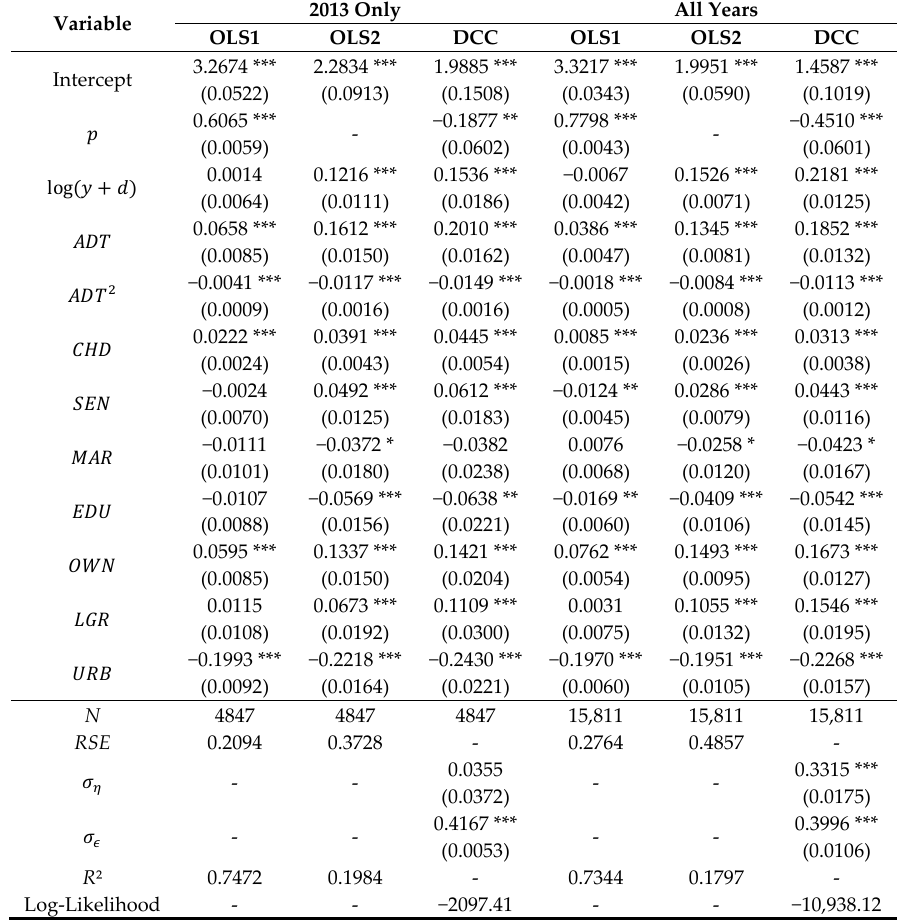
Table 2. Estimates of the natural logarithm of quarterly household water demand under various models.